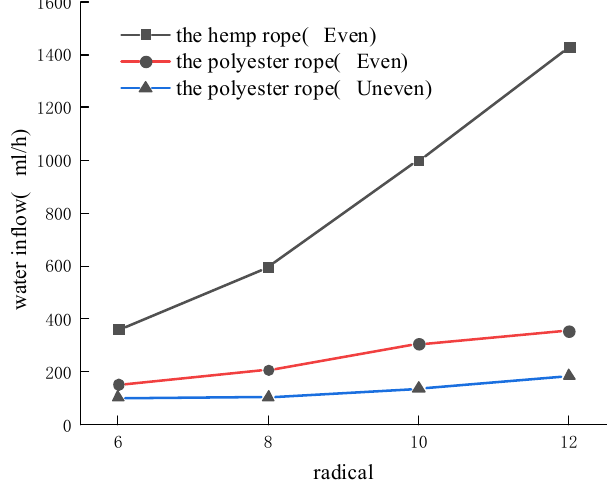
Figure 18. A seepage effect diagram of the Hemp/polyester rope fiber bundle.